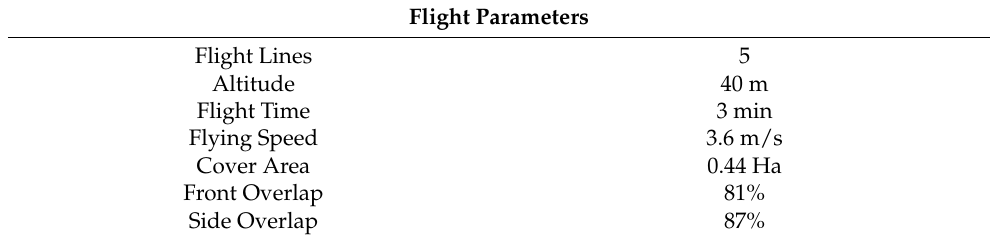
Table 6. Flight parameters.